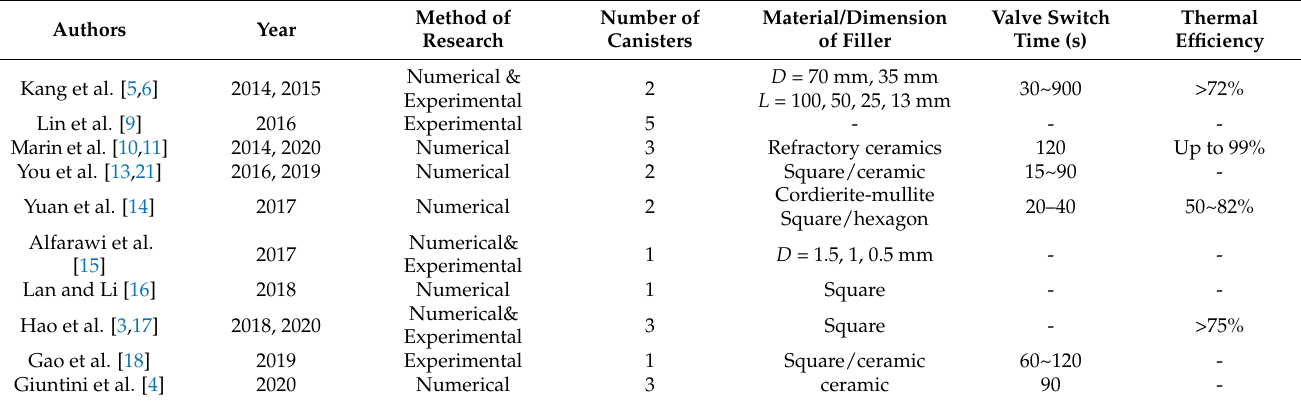
Table 1. Comparison of recent regenerative thermal oxidizer (RTO) studies (listed in chronological order).